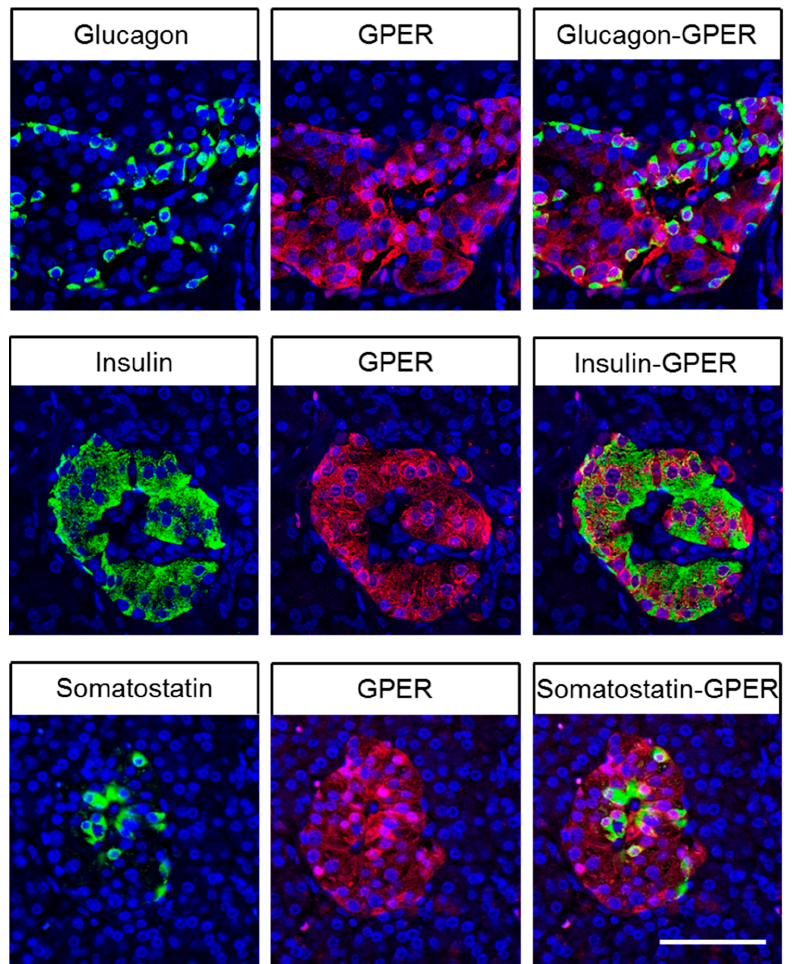
Figure 4. Double-labelling immunohistochemical analysis of human pancreatic islets. Sections were dewaxed and microwaved in citric acid. Adjacent sections of each tissue sample were incubated with rabbit monoclonal anti-GPER antibody 20H15L21 together with mouse monoclonal antibodies against glucagon or insulin, or a rat antibody against somatostatin-14/28. Labelling for GPER was visualised using a Cy3-conjugated anti-rabbit antibody (red), and labelling for insulin, glucagon, or somatostatin-14/28 was visualised using an Alexa Fluor 488-conjugated anti-mouse or anti-rat antibody (green). Scale bar: 100 µ